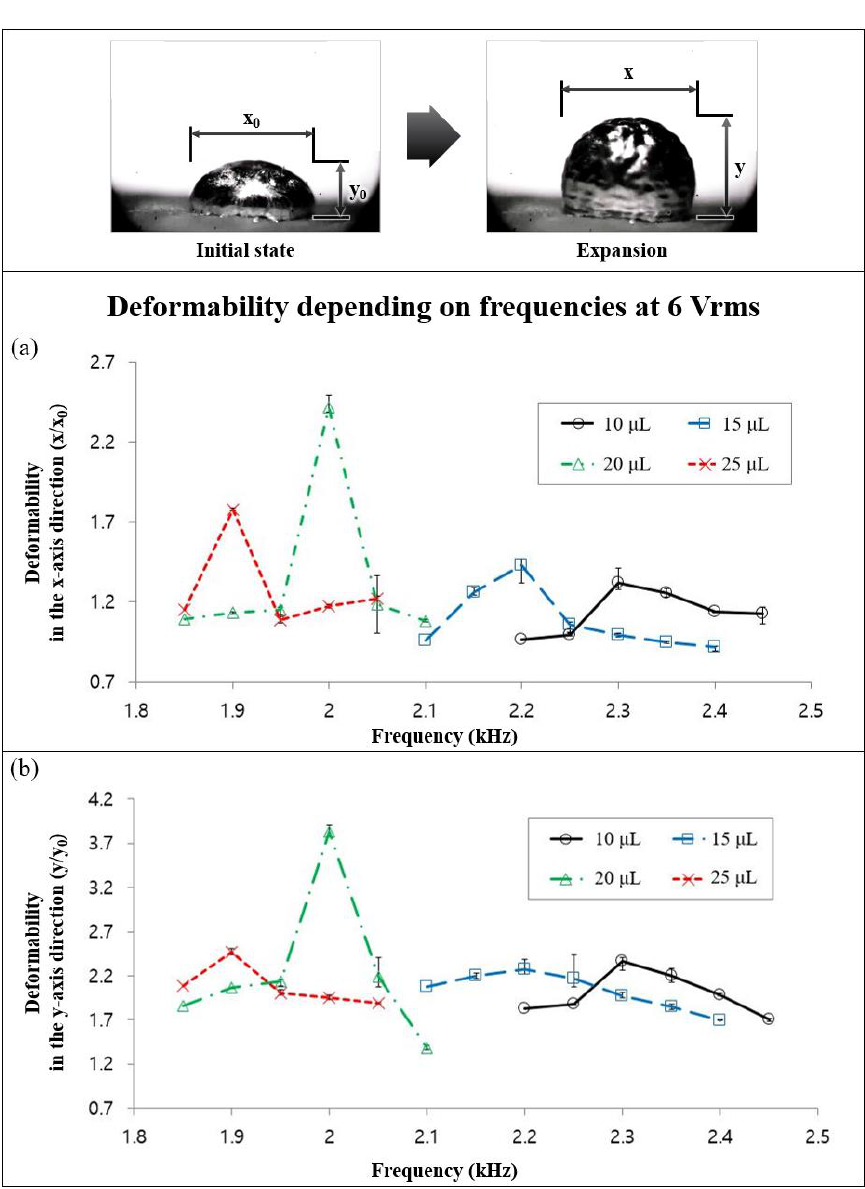
Figure 3. The deformability of liquid metal droplets in the ( a ) x and ( b ) y -axis direction, depending on applied frequencies from the amplifier.